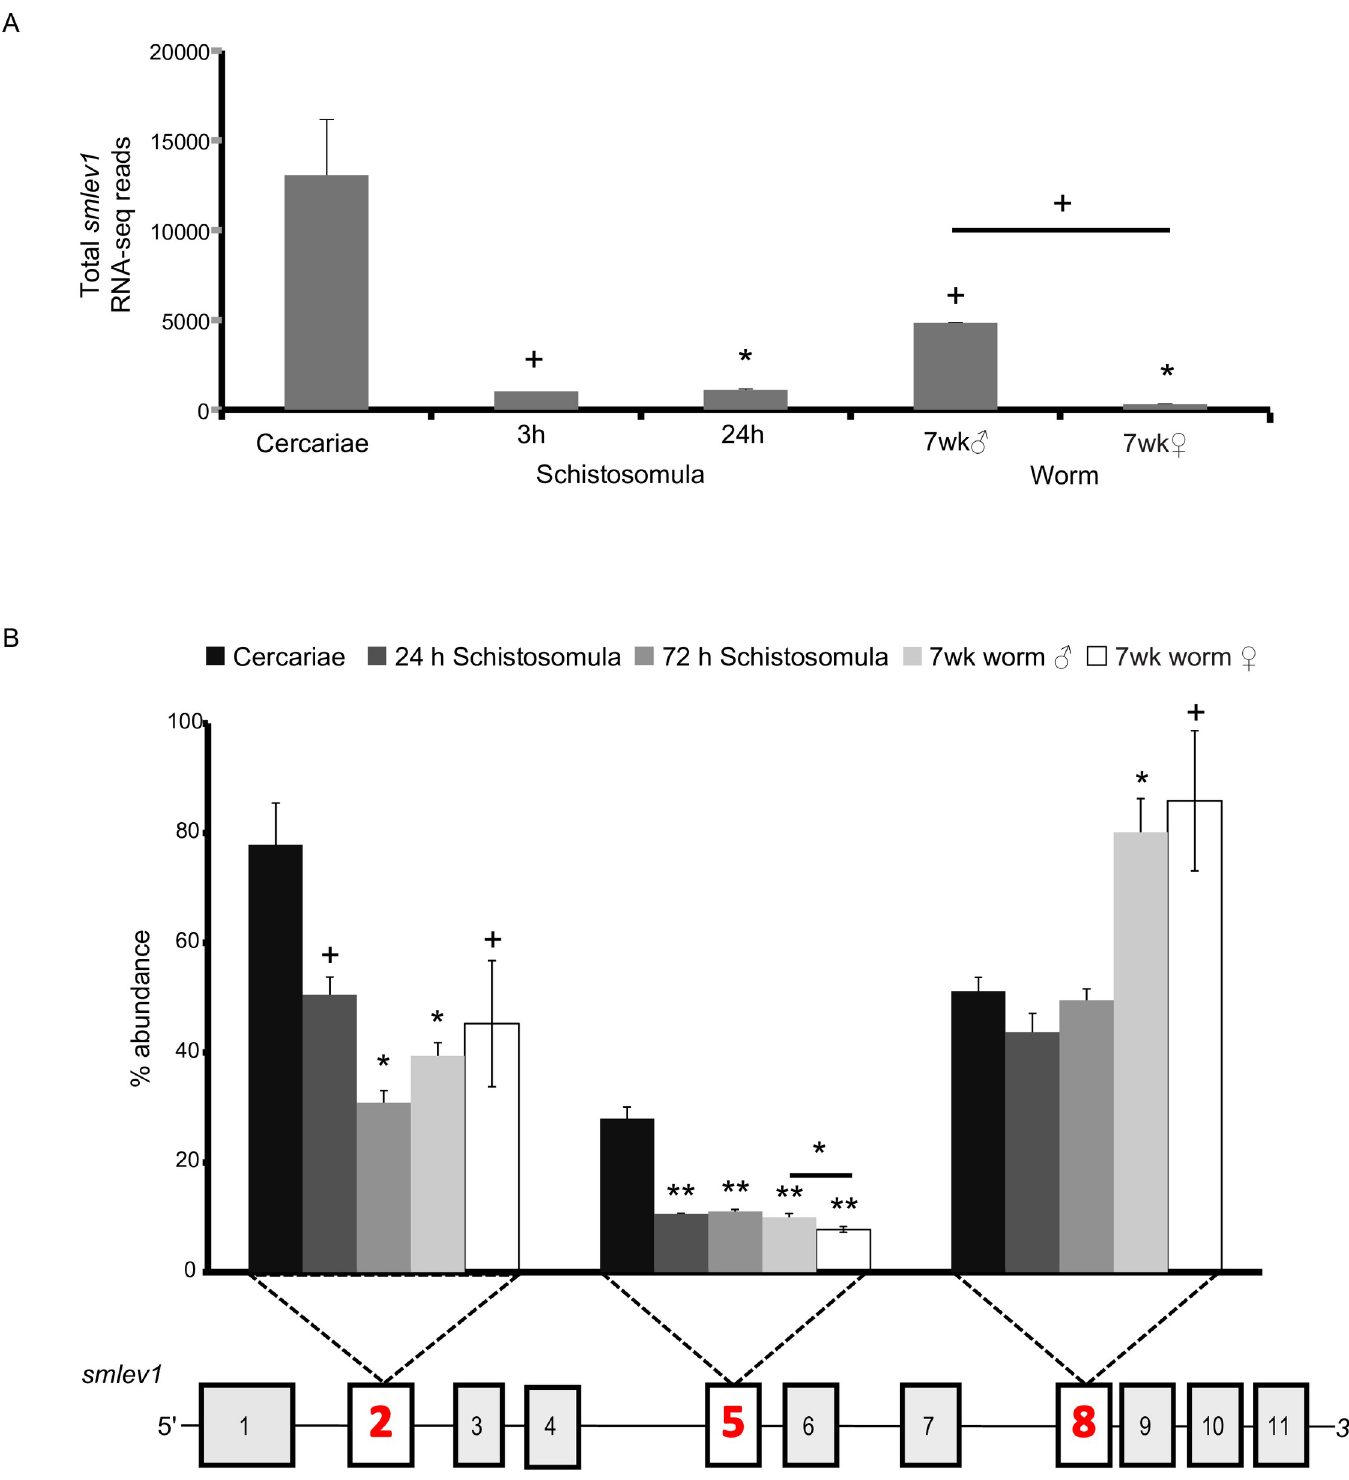
Fig 2. smlev1 is differentially spliced across the schistosome lifecycle. (A) The smlev1 transcript is enriched in cercariae, validating previous RNA-seq data, and shows a 15.5-fold male-bias expression in the adult worm [18]. The total smlev1 reads is shown on the y axis and lifecycle stage on the x axis; error bars represent standard deviation. (B) Abundance of three variable smlev1 exons, represented as a % of total transcript. Each cluster of columns reflects one variable exon (shown in red bold numbering) with individual columns for each lifecycle stage, shown in the legend. In both figures, significance (determined by ANOVA and post-hoc T-test analysis) is expressed as p < 0.05 +, p < 0.01 � , or p < 0.005 �� ; p < 0.001 ��� .